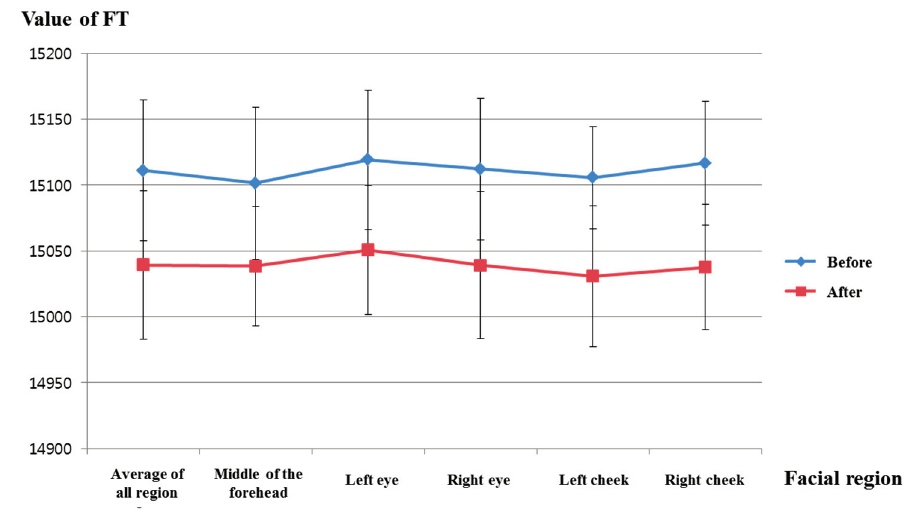
Figure 14. Comparisons of FTs of facial feature regions before and after watching the horror movie (FT is facial